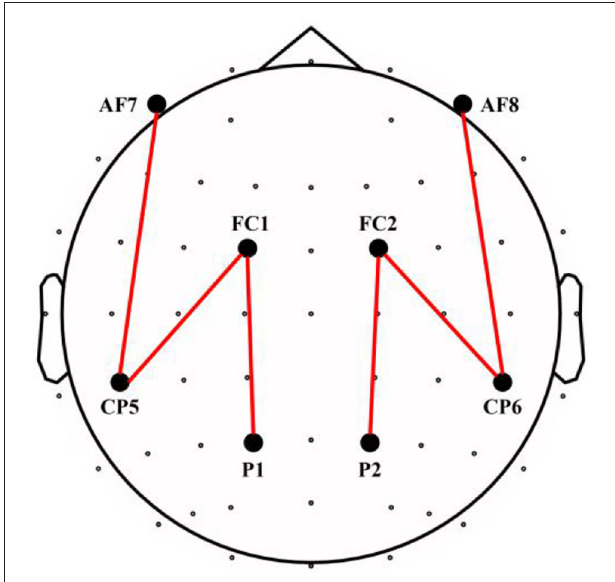
FIGURE 2 | Electrode pairs for the frontoparietal network.